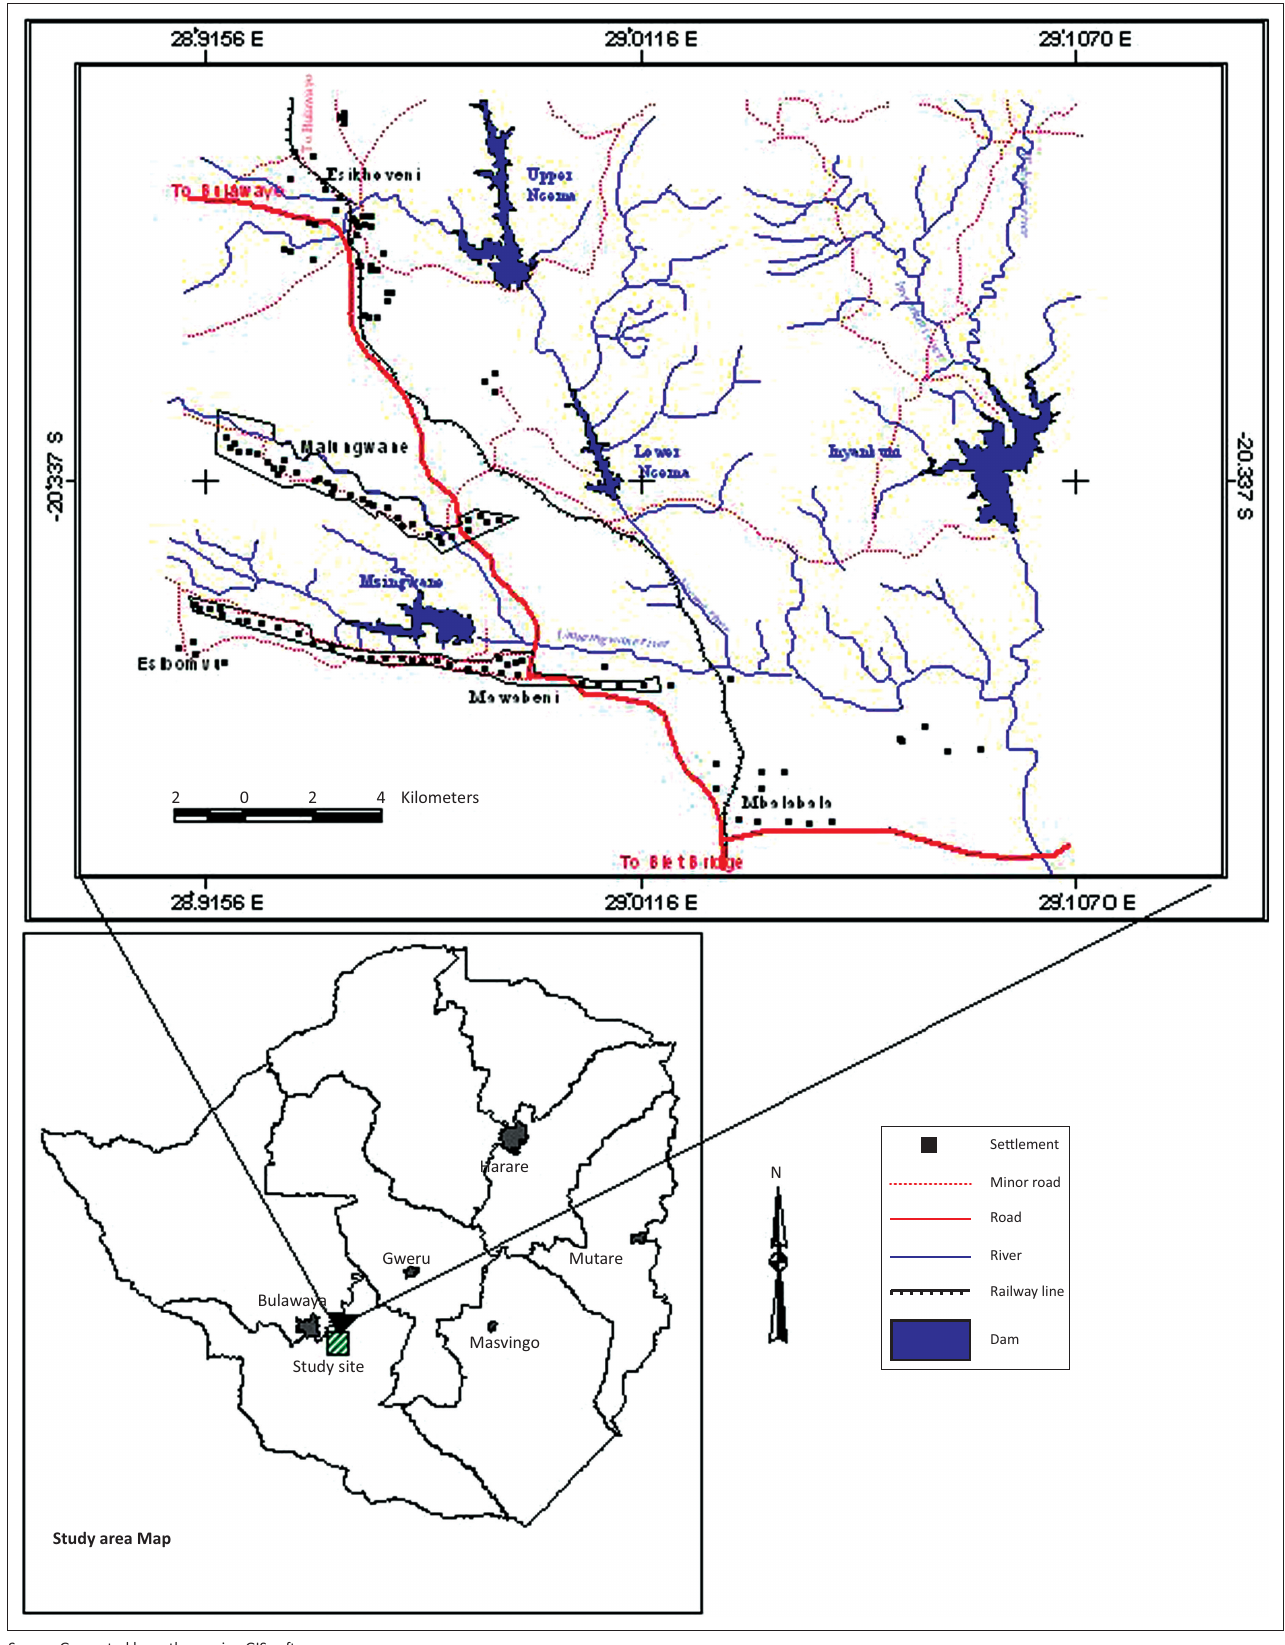
FIGURE 1: Mzingwane District study